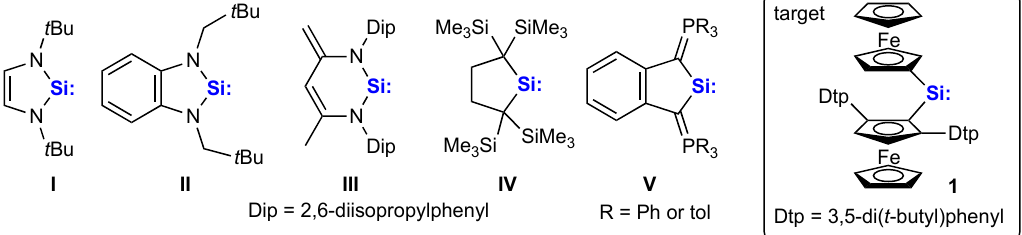
Chart 1. Examples of isolable dicoordinated silylenes.